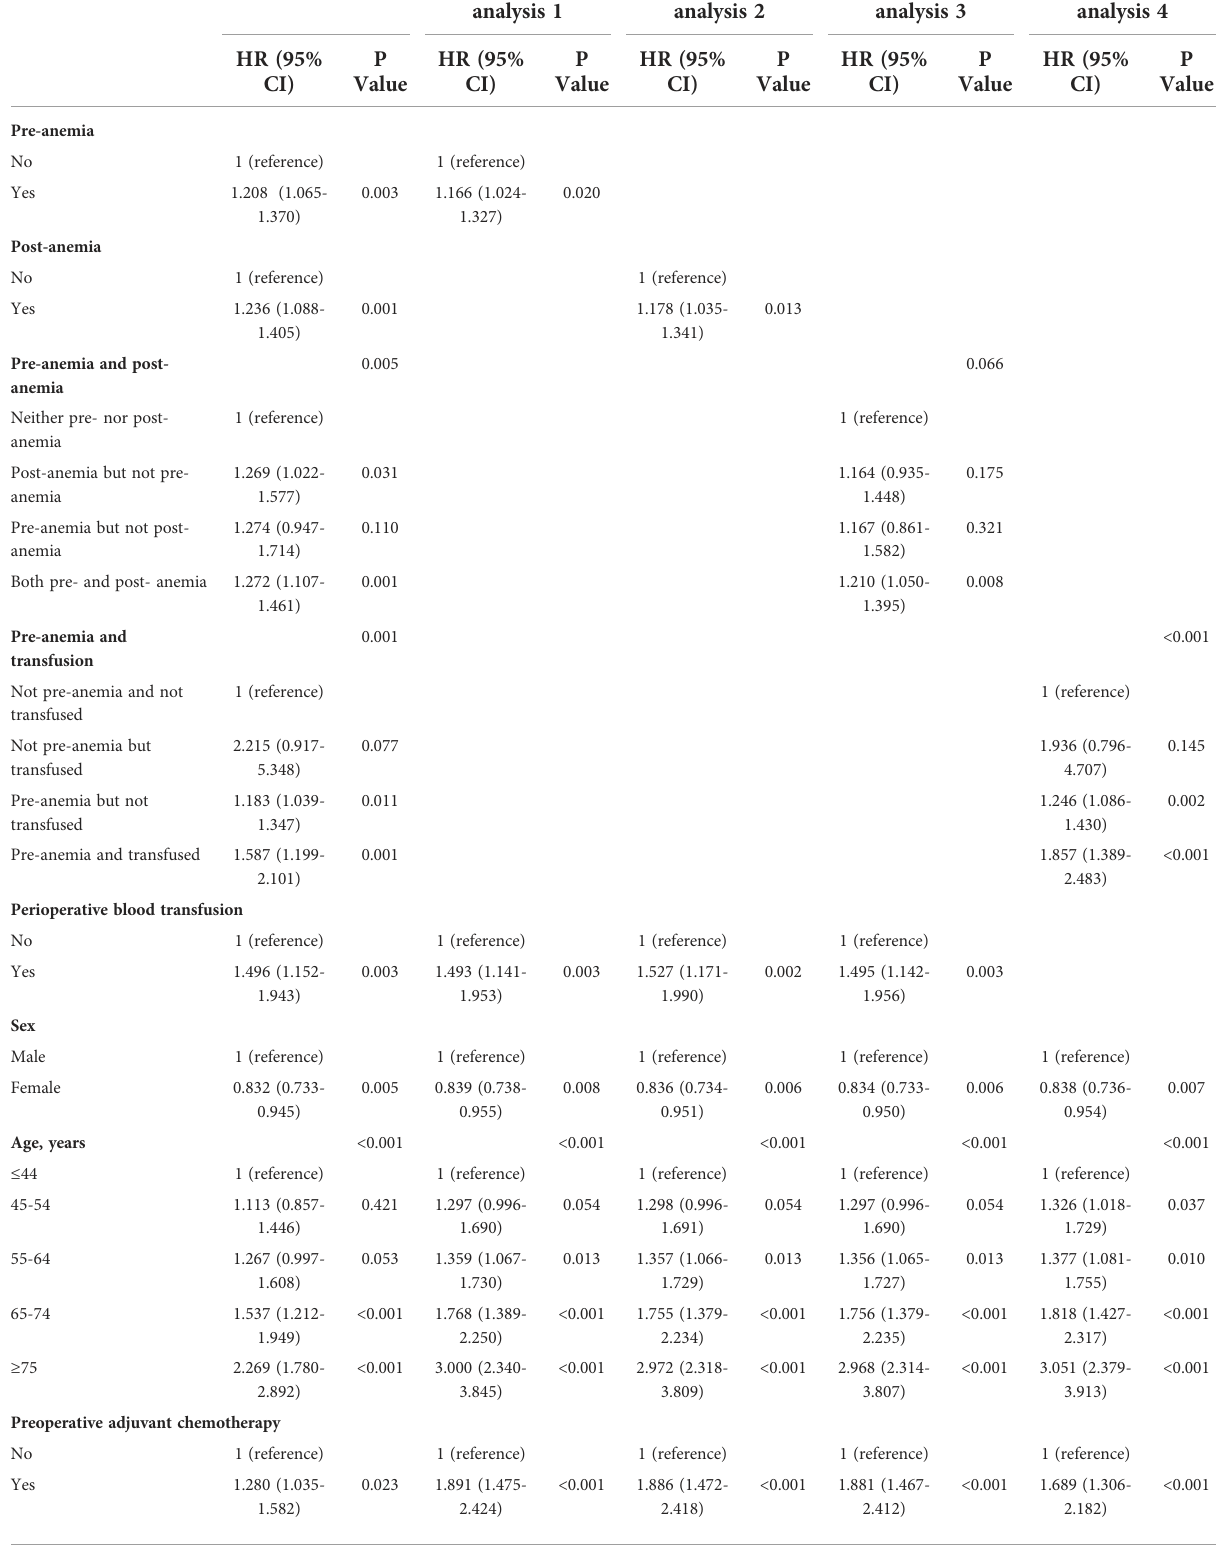
TABLE 4 Univariate analysis and multivariate Cox regression analysis for disease-free survival in the Propensity score matched